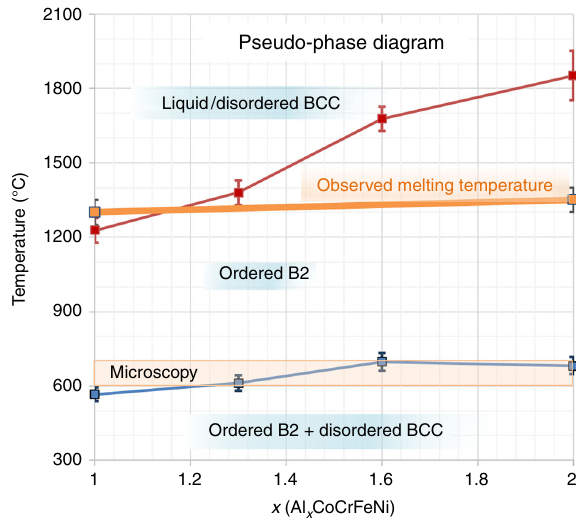
Fig. 7 Schematic phase diagram for solid phases of Al x CoCrFeNi in the range from 1 < x < 2. This diagram captures the simulated trends in B2- ordering temperature with Al content (red data points) and the temperature at which the primarily Cr-Fe BCC phase develops (blue data points). Note that above ~1300°C, the solid is observed to melt (orange line); thus, for higher Al content, the melt will crystallize into the B2 phase, as observed in scattering experiments presented in Fig. 4. The lower transition is also marked by the 600 – 700 °C range of temperatures where in situ microscopy demonstrates a change in the microstructure, as shown in Fig.